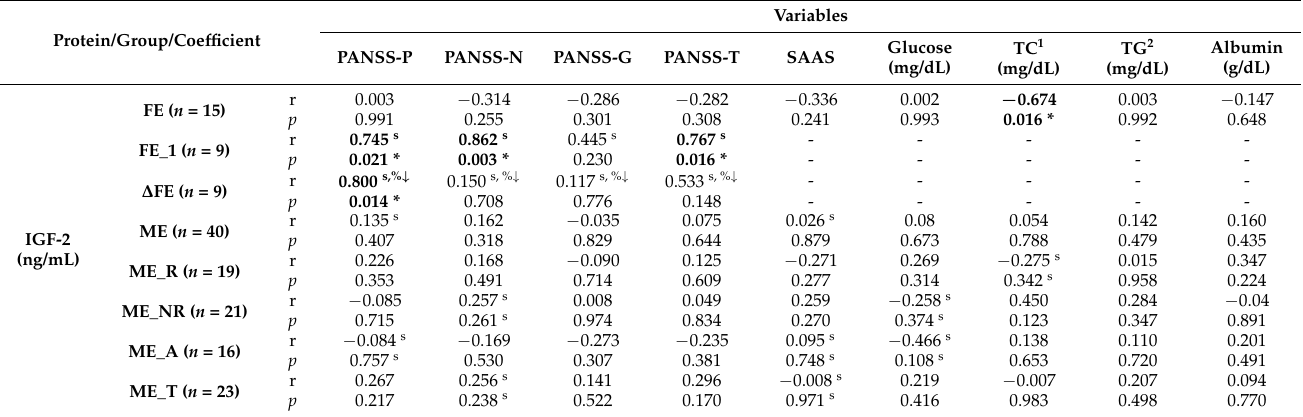
Table 2. Correlation between IGF-2 and variables.